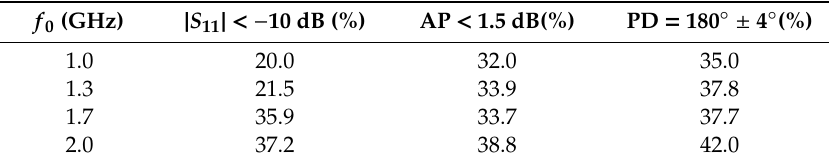
Table 4. Relative bandwidth of the fabricated tunable balun.